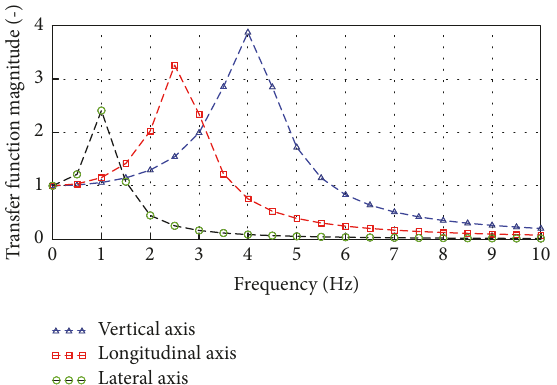
Figure 15: Transfer functions between the seat and the coach floor along the longitudinal, lateral, and vertical direction.